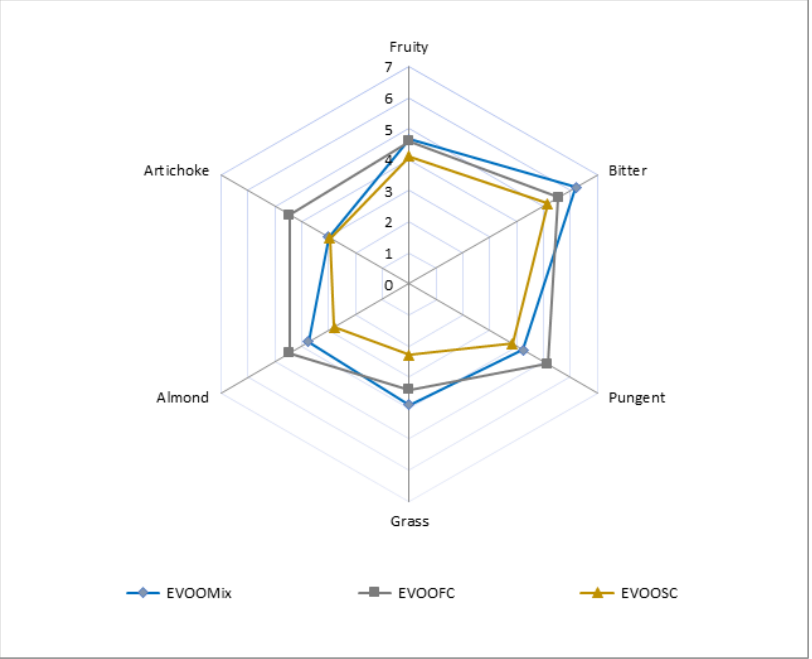
Figure 3. Sensory profile of the Mixed, First Choice and Second Choice EVOOs analyzed, i.e., EVOOMix, EVOOFC and EVOOSC respectively.